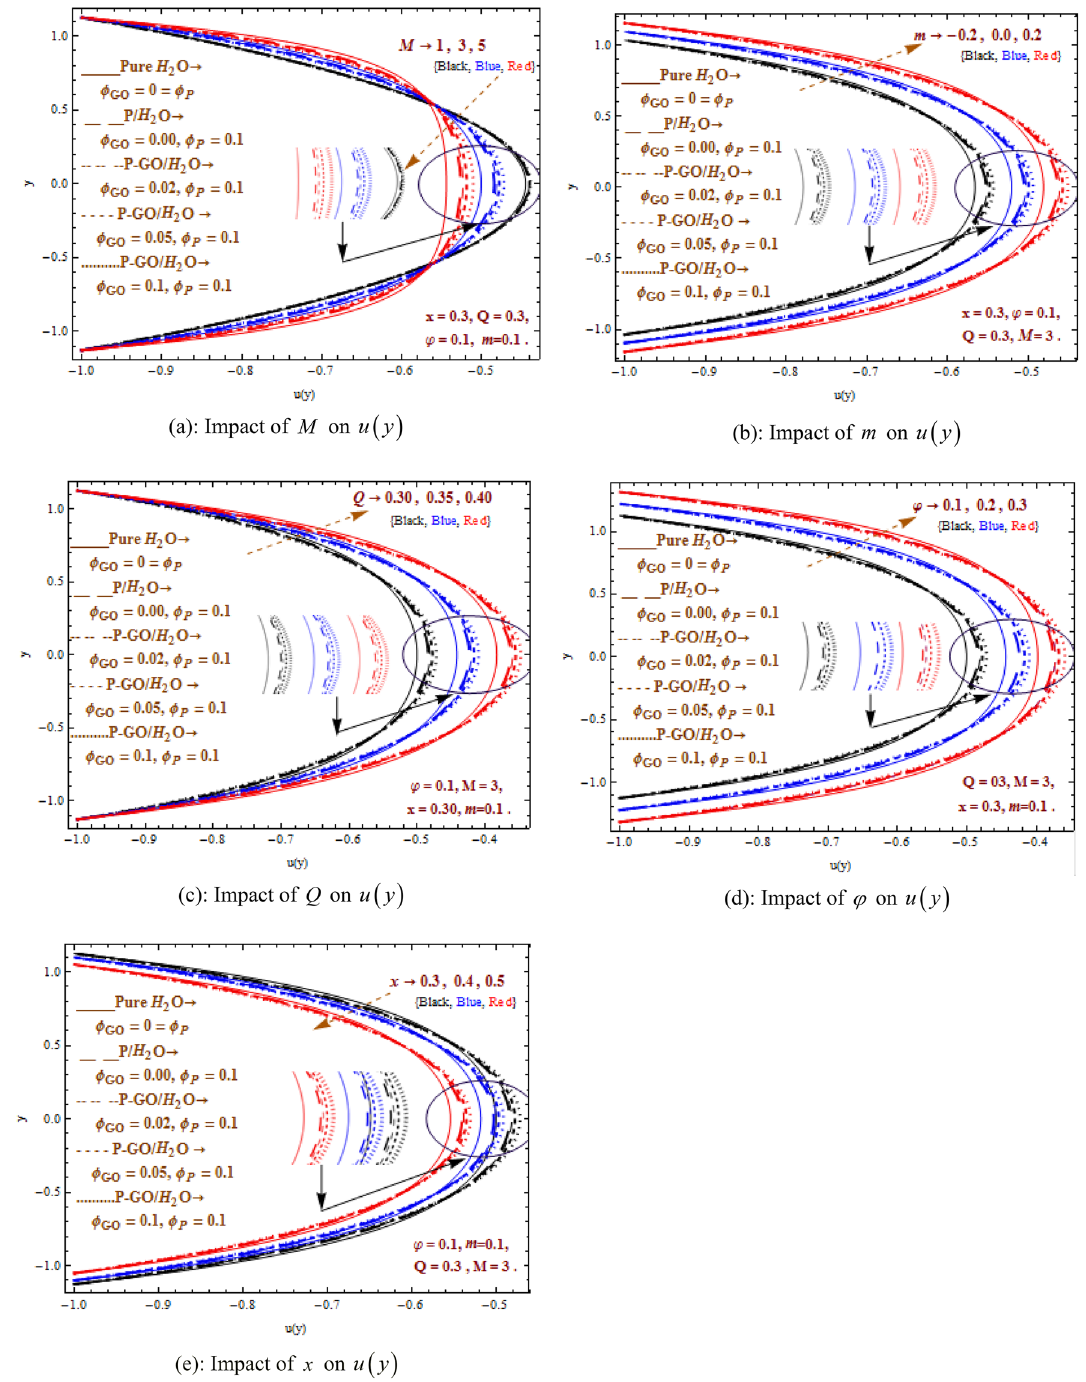
Figure 5. ( a ) Impact of M on